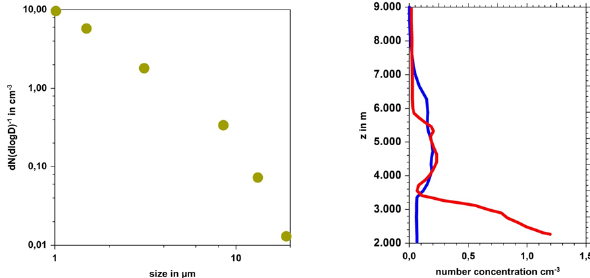
Figure 5. Left: measured size distributions close to the volcano on 2 May, 2010. Right: measured (red) and simulated (blue) number concentrations for particles greater than 2µm at Leipzig on 17 April 2010. Measured data taken from Schumann et al.